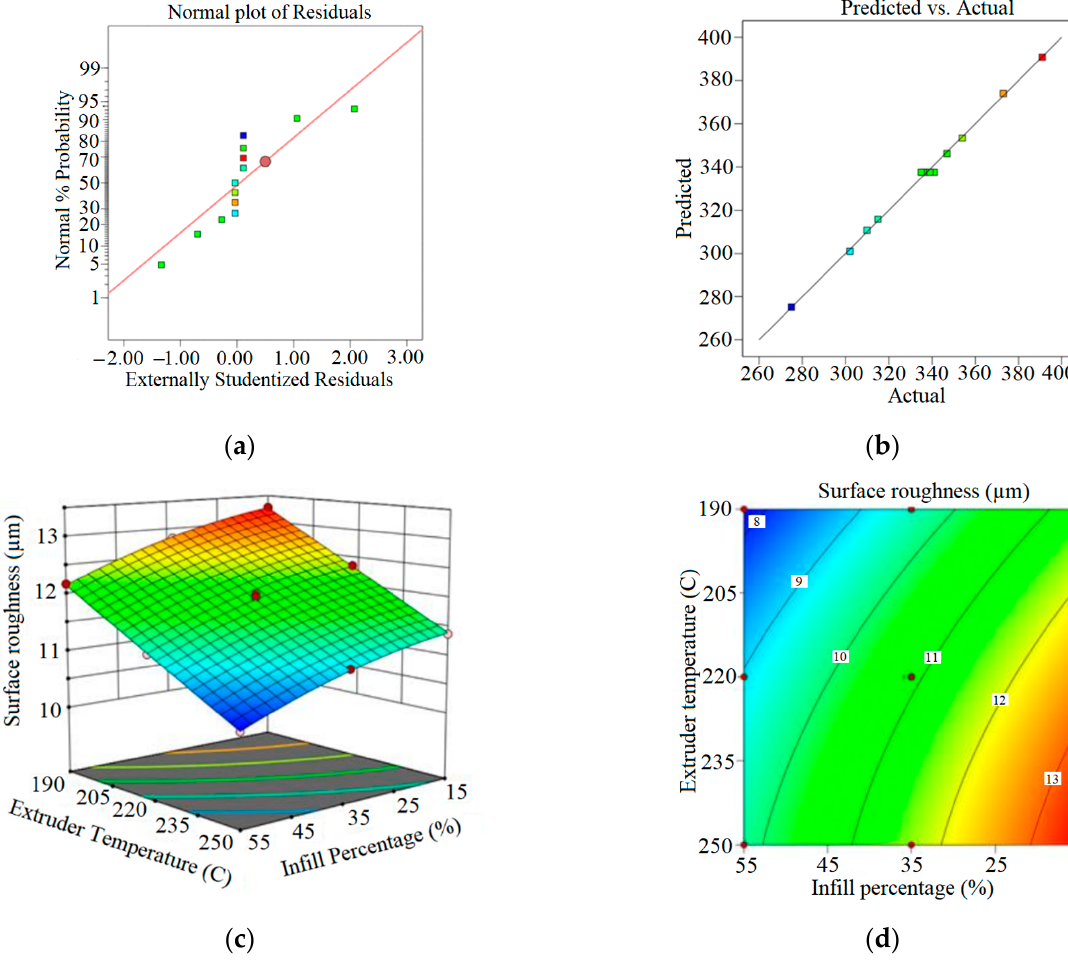
Figure 5. Surface roughness diagrams of ( a ) residuals plot, ( b ) response surface plot of IP and ET, ( c ) actual vs. predicted plot, and ( d ) contour plot of IP and ET.